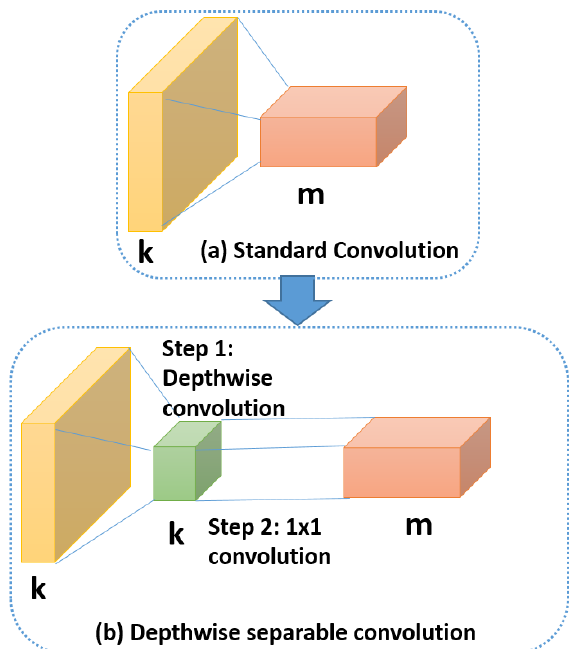
Figure 10. Depthwise Separable Convolution.